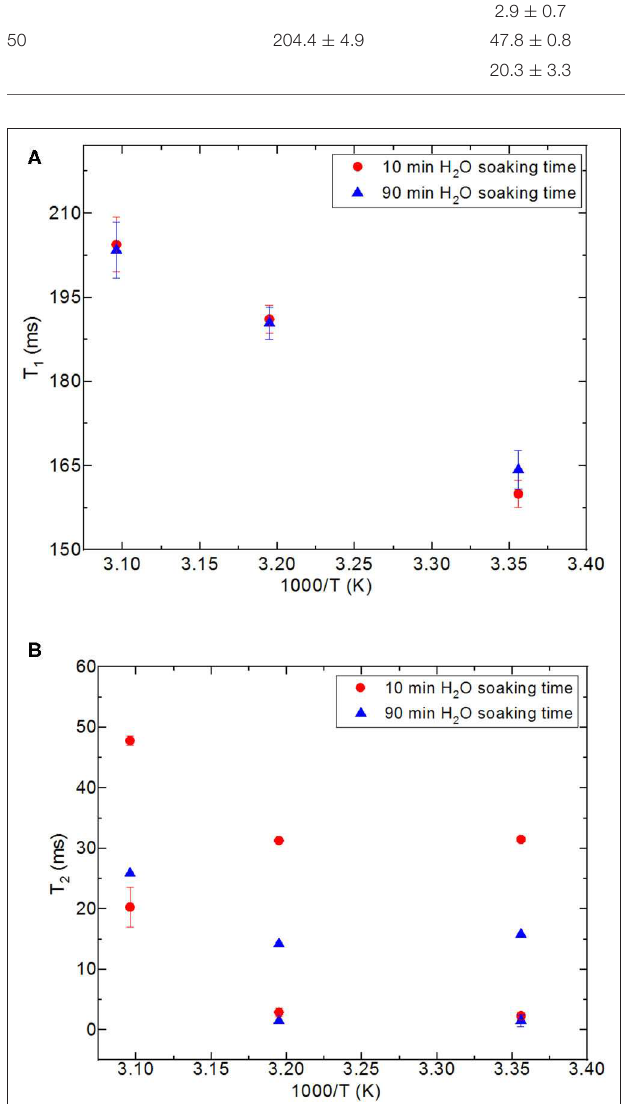
FIGURE 6 | Comparison of relaxation values of H 2 O confined into 6nm silica rod at 298, 313, and 323K, and with 10 and 90min of water soaking times; T 1 (A) , T 2 (B) .